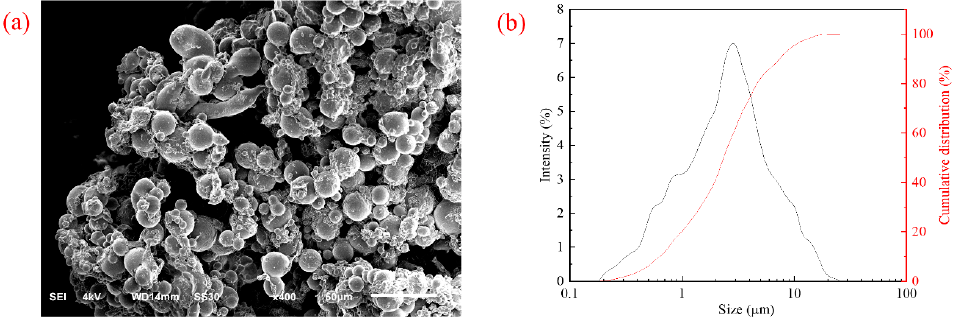
Figure 8. (a) SEM image and (b) particle size distribution.